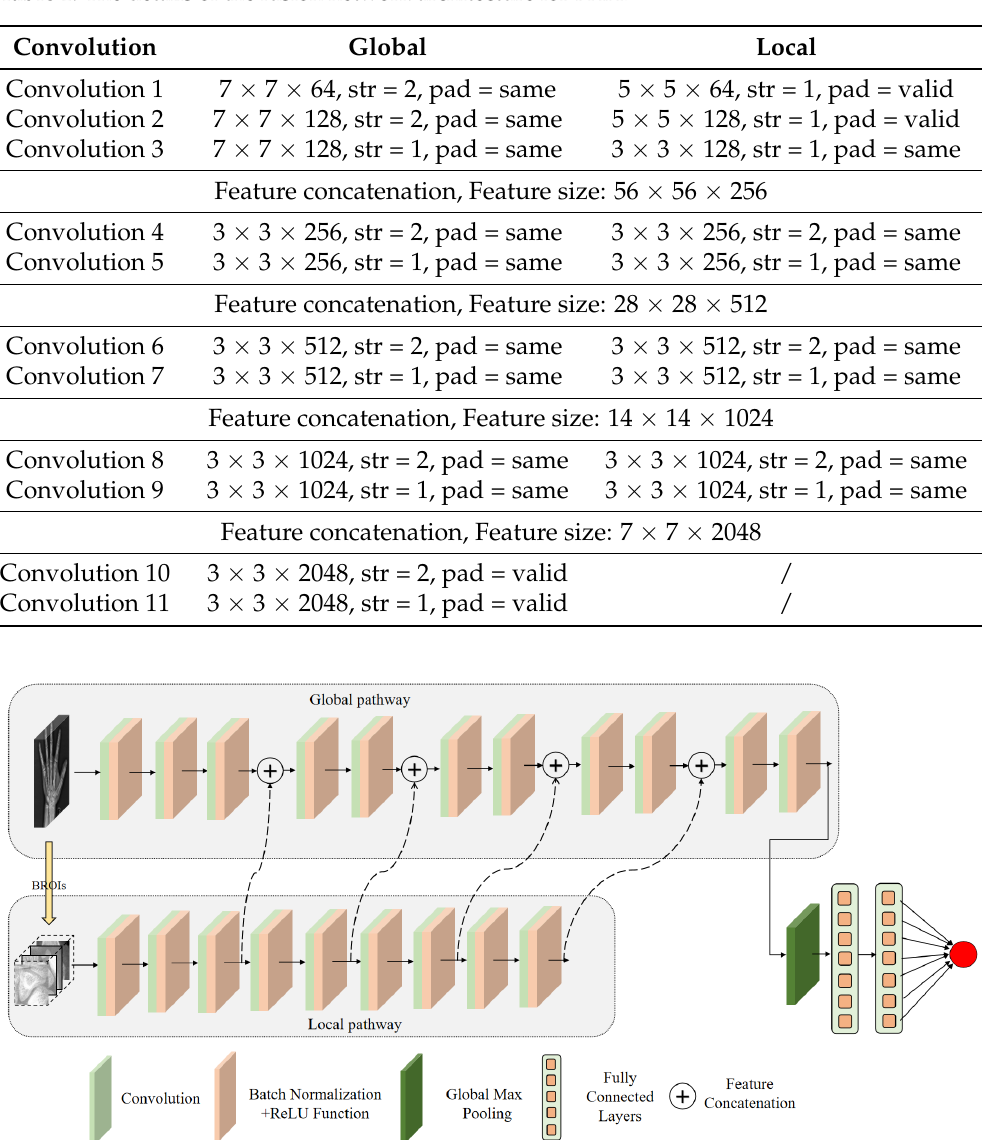
Table 1. The details of the fusion network architecture for BAA.